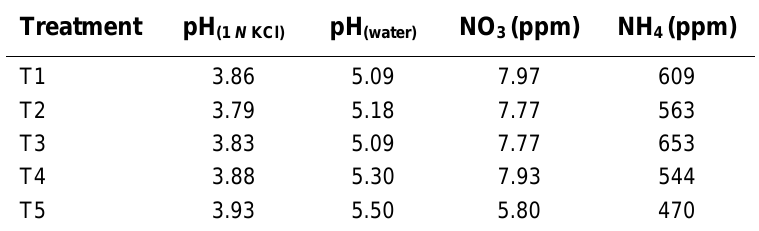
Soil pH, Soil Available Nitrate, and Soil Exchangeable Ammonium at 90 DAP